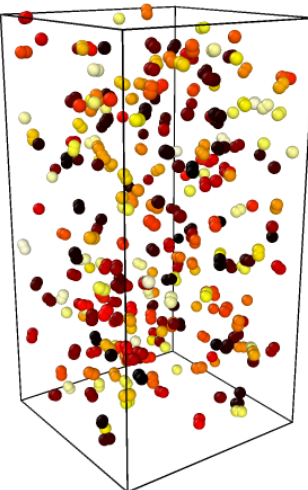
Figure 7. Location of the first 100 swaps after the two pieces are put in contact. Near the cut, swap happens with the same probability as in the bulk. Healing is then determined by equilibrium swap